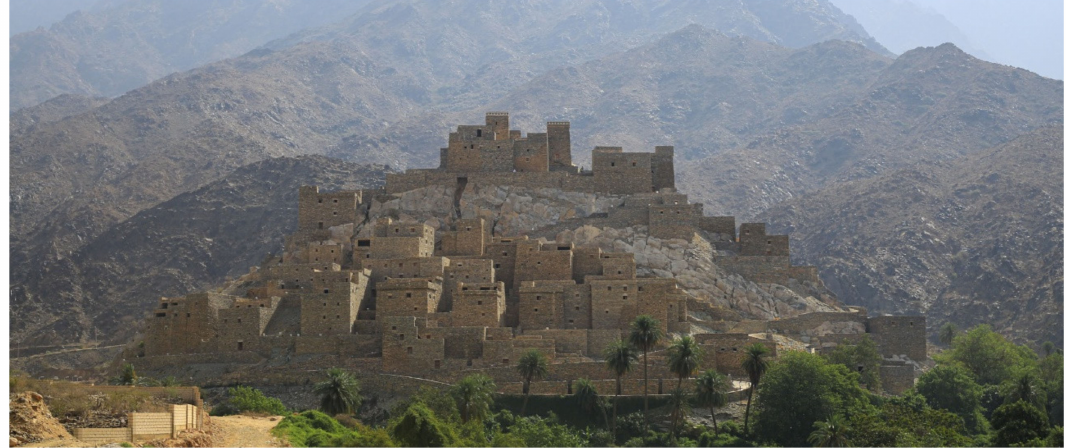
Figure 2. Zee Ain historical